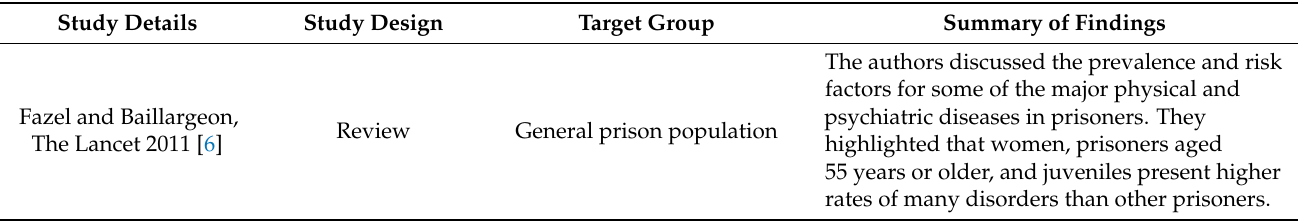
Table 2. Summary of findings of the nine studies evaluating the health conditions in